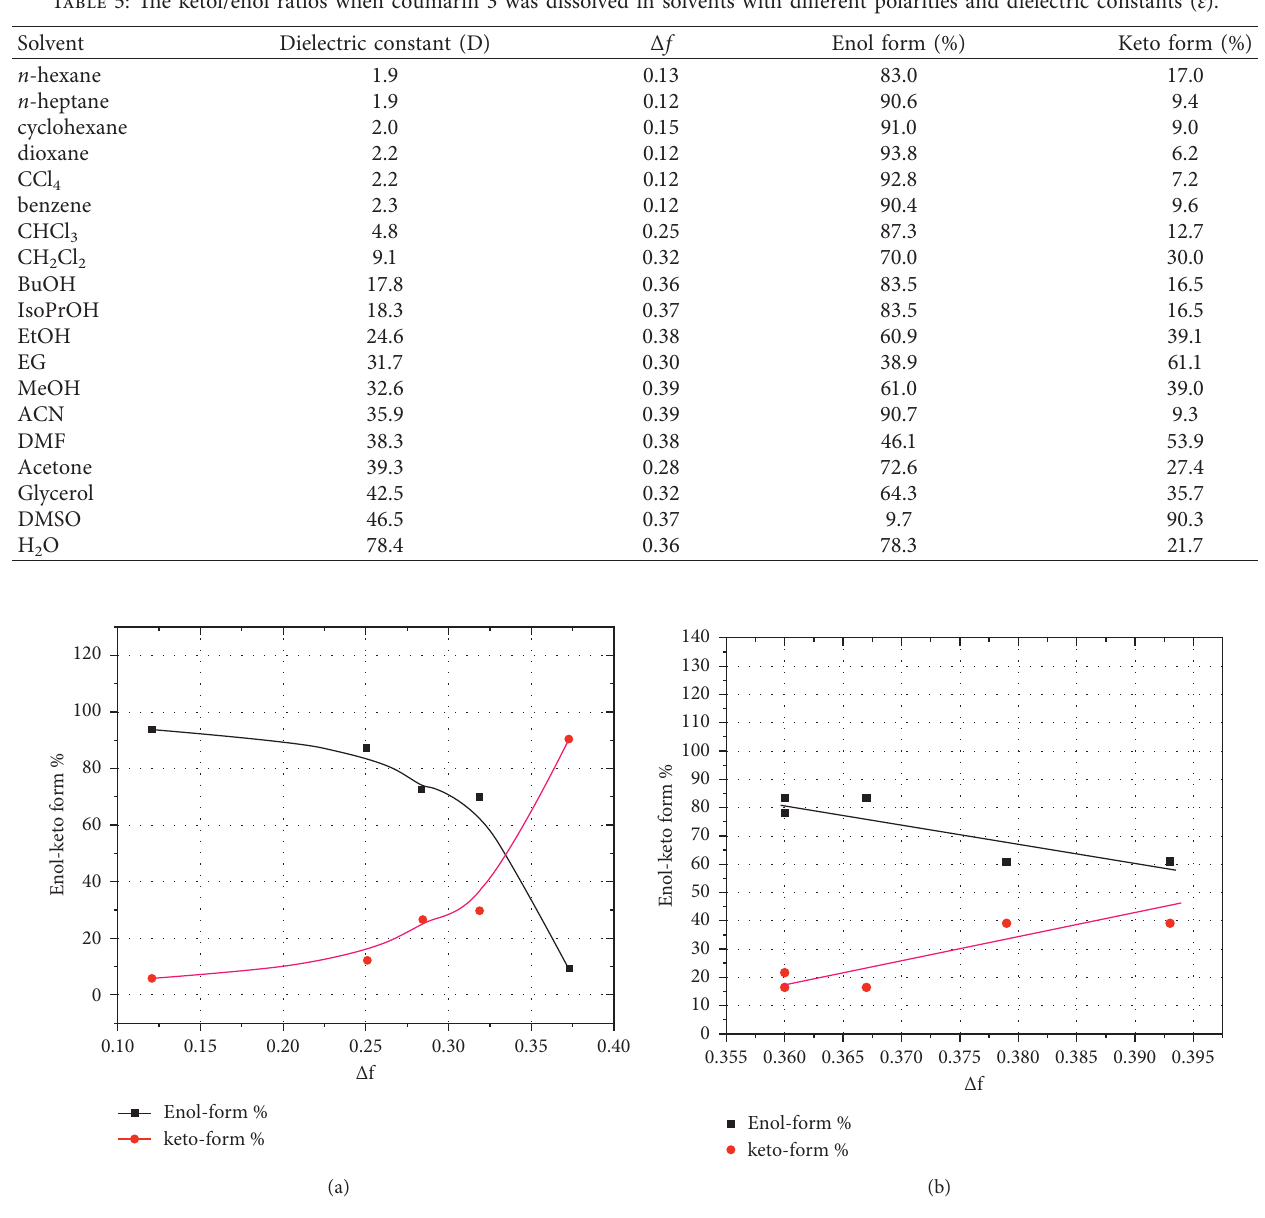
Figure 10: Changes in the keto/enol ratios of coumarin 3 as a function of solvent polarity for aprotic (a) and protic (b)